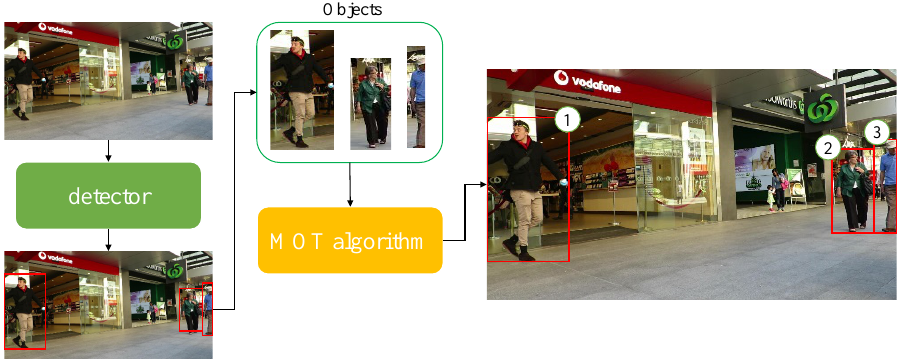
Figure 1. The explanation of the ID assignment method, which is one of the main concepts of MOT using the MOT15 benchmark dataset [8]. Objects in the current frame are first detected using the detector. The detected result is then fed into an MOT algorithm to assign the ID for each object.